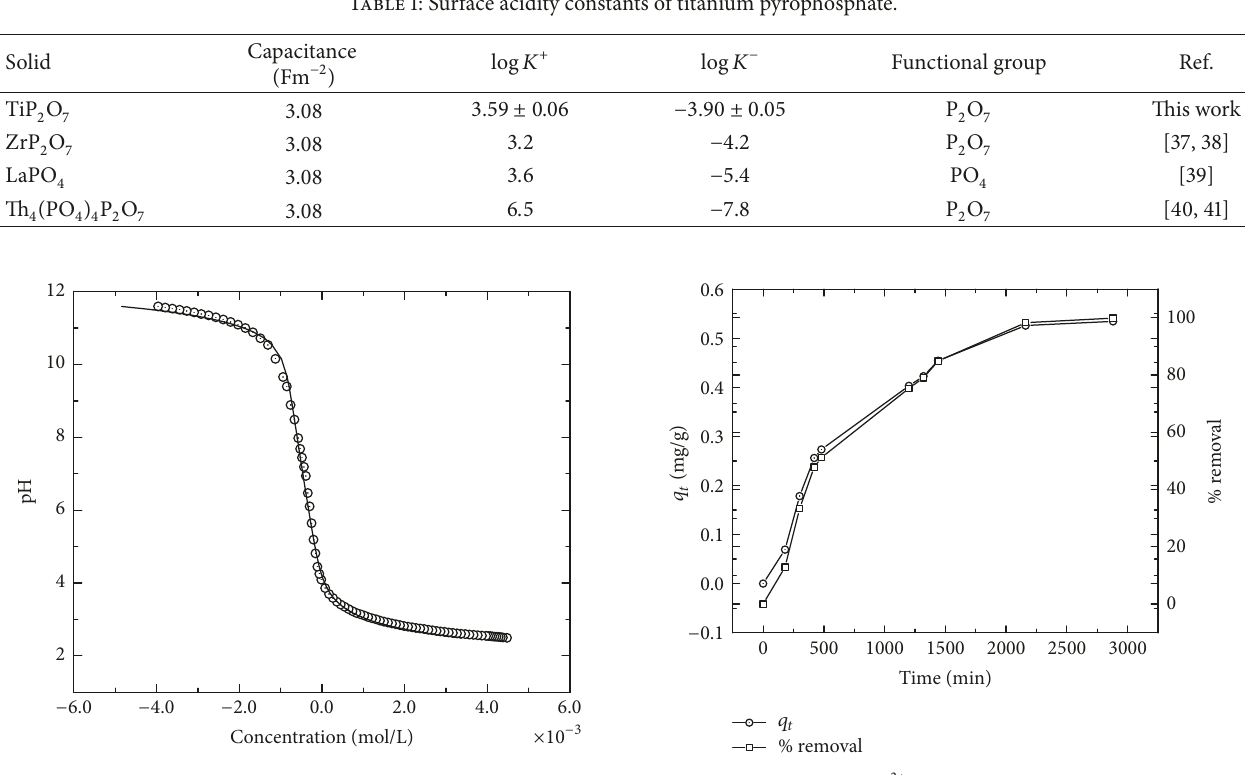
Figure 7: Sorption of Eu 3+ as a function of time in the solid synthetized, using 1 × 10 −4 M solution of EuNO 3 , in contact with 400 mg of solid at pH